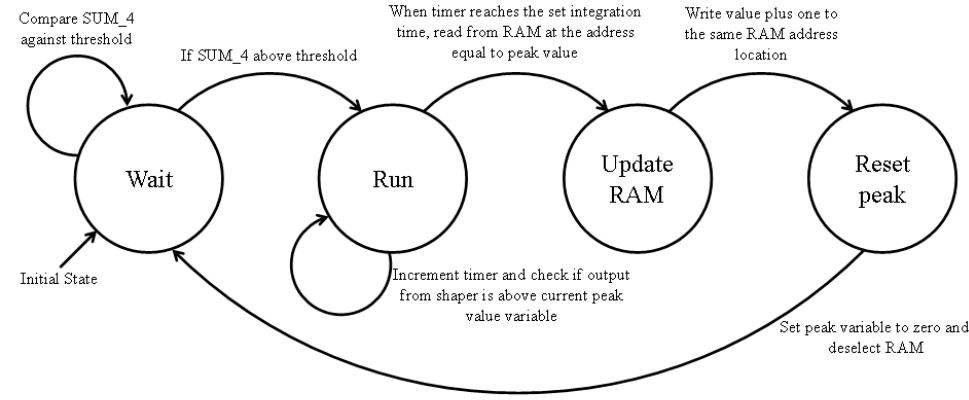
Figure 10. Finite state machine of the pulse peak storage system implemented on Cyclone II FPGA. Each transition occurs every clock cycle. The variable SUM_4 is the output of the shaper algorithm.